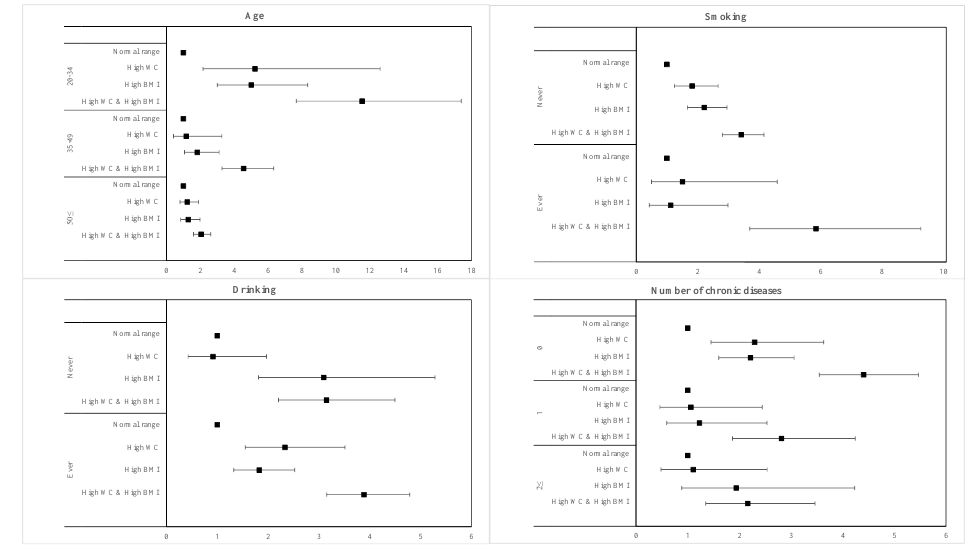
Figure 2. Forest plots of subgroup analysis results in